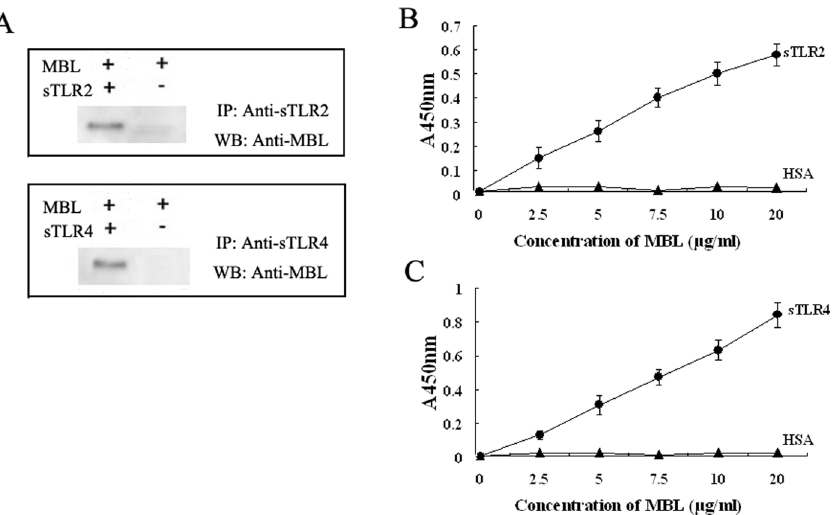
Figure 9. MBL binds to sTLR2 and sTLR4. (A) 2 m g of MBL were incubated with sTLR2 or sTLR4 followed by incubation with anti-sTLR2 pAb or anti-sTLR4 pAb, respectively. The immune complexes were precipitated with protein G-Sepharose and subjected to SDS-PAGE under reducing conditions. The proteins on the gel were transferred to polyvinylidene difluoride membrane and immunoprobed with anti-human MBL monoclonal antibody as described under ‘‘Materials and Methods’’ IP, immunoprecipitate; WB, Western blot. sTLR2 (B) or sTLR4 (C) was coated onto microtiter wells and incubated with the indicated concentrations of MBL, respectively. The binding of MBL to sTLR2 and sTLR4 was detected by anti-MBL mAb, as described under ‘‘Materials and Methods’’. The data shown are mean 6 S.E. of three